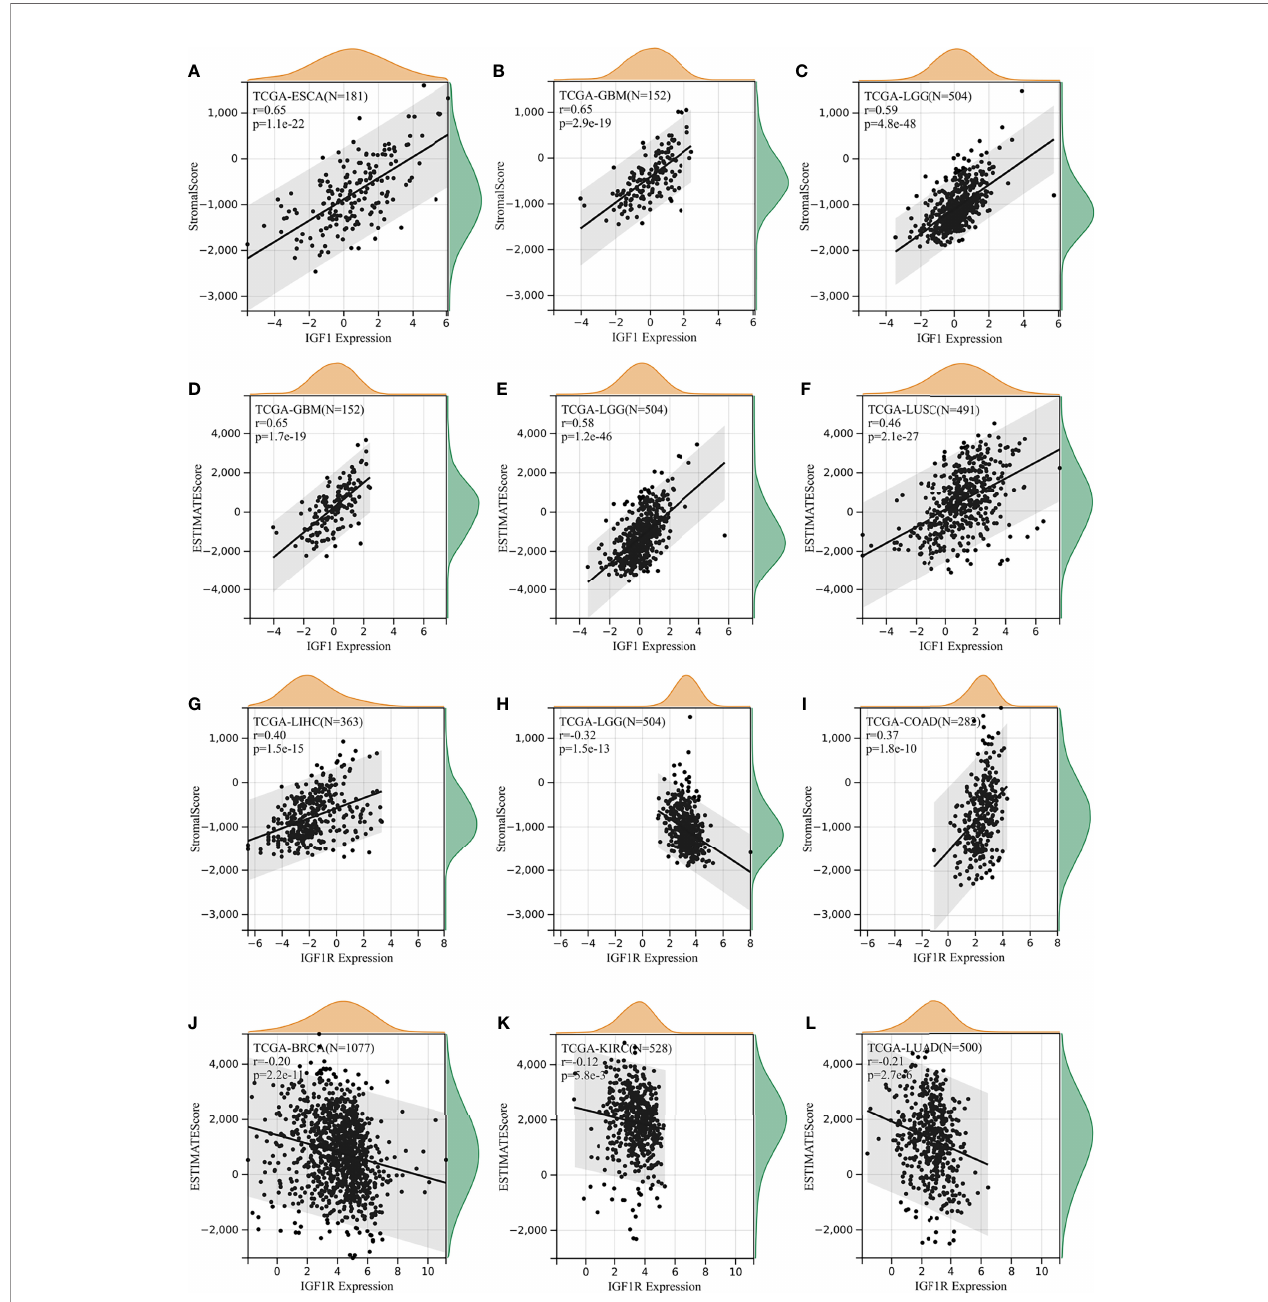
FIGURE 5 | Correlation of IGF-1/IGF-1R expression with estimate score. (A – C) IGF-1 expression signi fi cantly correlated with stromal scores in esophageal carcinoma (ESCA), glioblastoma multiforme (GBM), and lower-grade glioma (LGG). (D – F) IGF-1 expression signi fi cantly correlated with immune scores in glioblastoma multiforme (GBM), lower-grade glioma (LGG), and lung squamous cell carcinoma (LUSC). (G – I) IGF-1R expression signi fi cantly correlated with stromal scores in liver hepatocellular carcinoma (LIHC), lower-grade glioma (LGG), and lung squamous cell carcinoma (LUSC). (J – L) IGF-1R expression signi fi cantly correlated with immune scores in breast invasive carcinoma (BRCA), kidney renal clear cell carcinoma (KIRC), and lung adenocarcinoma